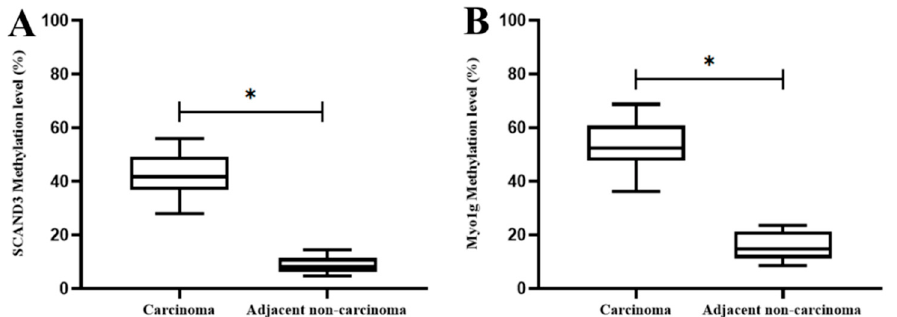
Figure 3. The methylation levels of SCAND3 and Myo1g in HCC tissues and adjacent non-cancerous tissues. ( A ) SCAND3 methylation ratios in cancerous tissues and adjacent noncancerous tissues were 41.79% and 8.73%, respectively; ( B ) Myo1g methylation ratios in cancerous tissues and adjacent noncancerous tissues were 53.43% and 15.67%, respectively. Statistical comparisons were computed using the unpaired t -test, * p < 0.05.